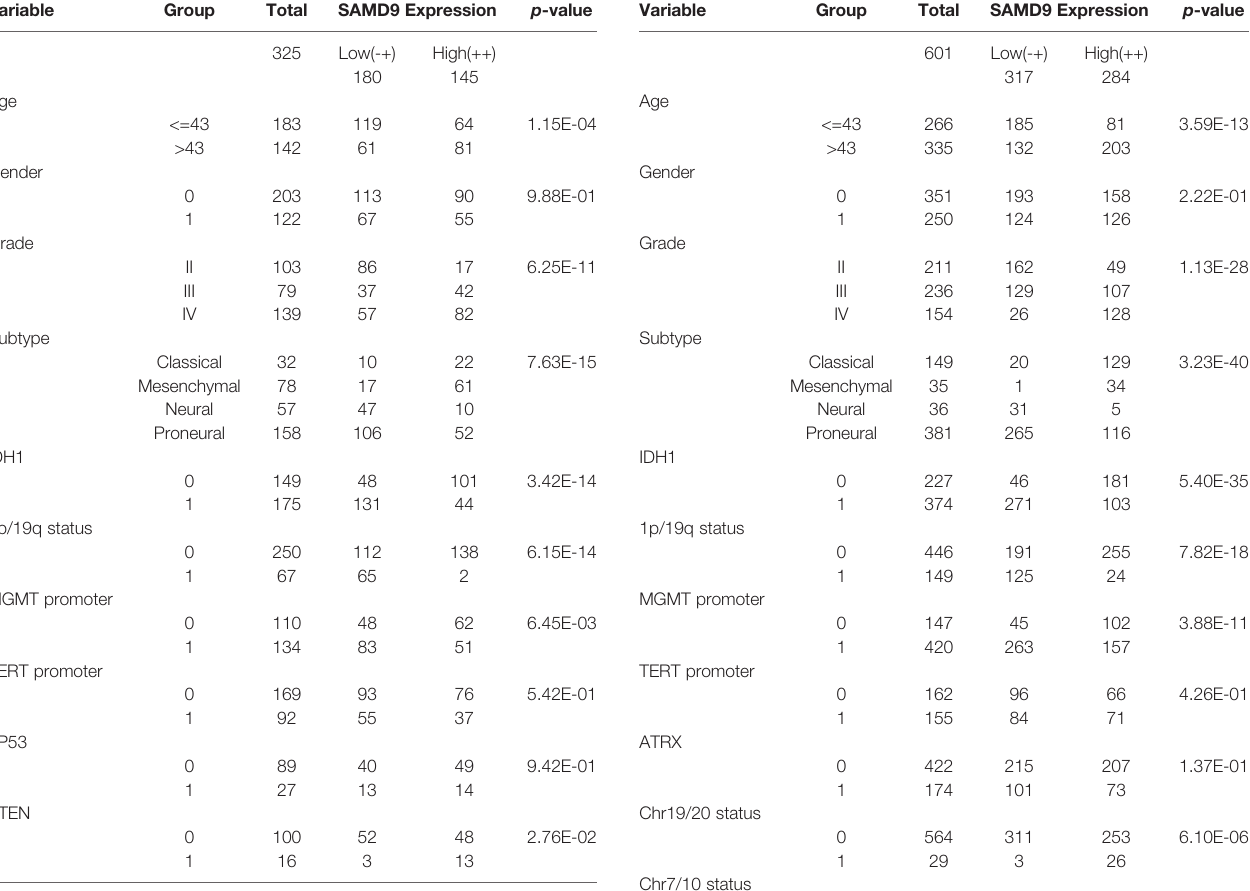
TABLE 1 | Clinicopathological of SAMD9 expression in CGGA database 1. Variable